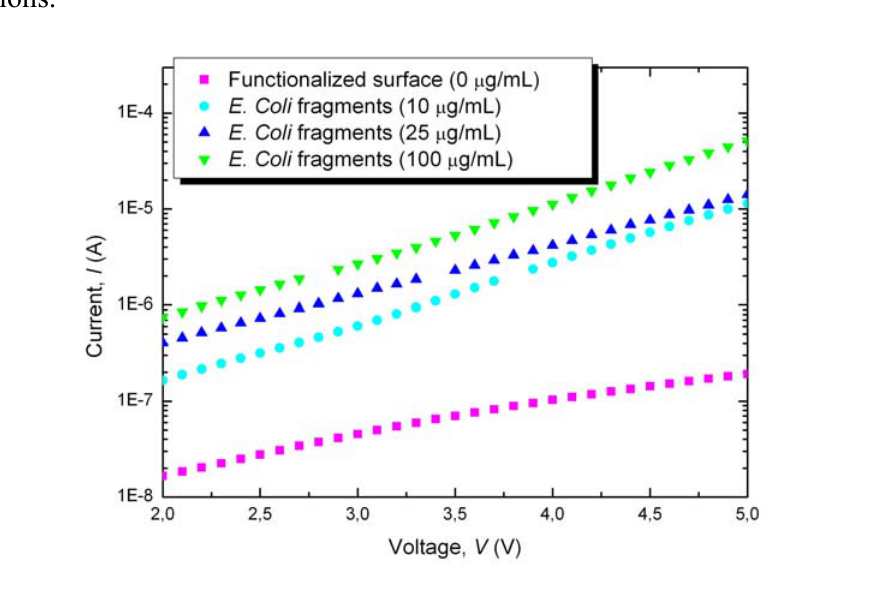
Figure 5. Current ( I ) as function of the applied voltage ( V ) through the Au- NiCr/nanoPS/Au-NiCr structure after probing with E. coli fragments at